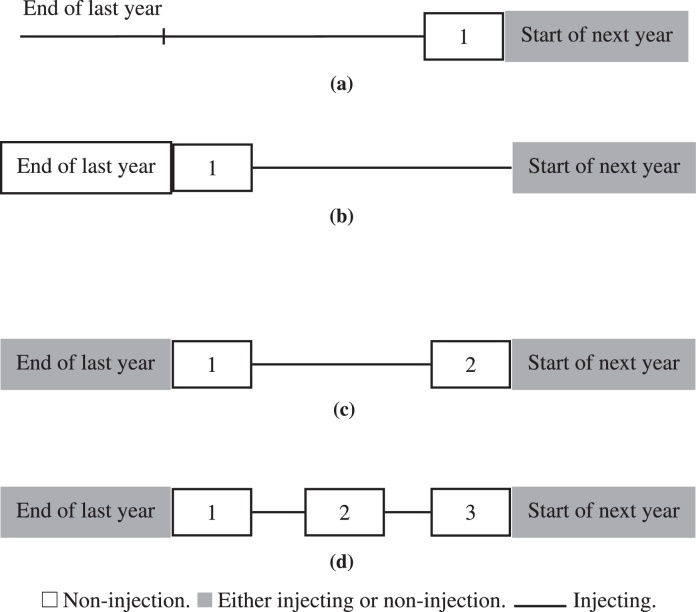
The assignment of non-injection periods for the 405 PWID in the EAC, United Kingdom, 1980–2006. (a) A single period of non-injection preceded by a period of injecting. (b) A single period of non-injection preceded by a period of non-injection. (c) Two non-injection periods within 1 year. (d) Three non-injection periods within 1 year.